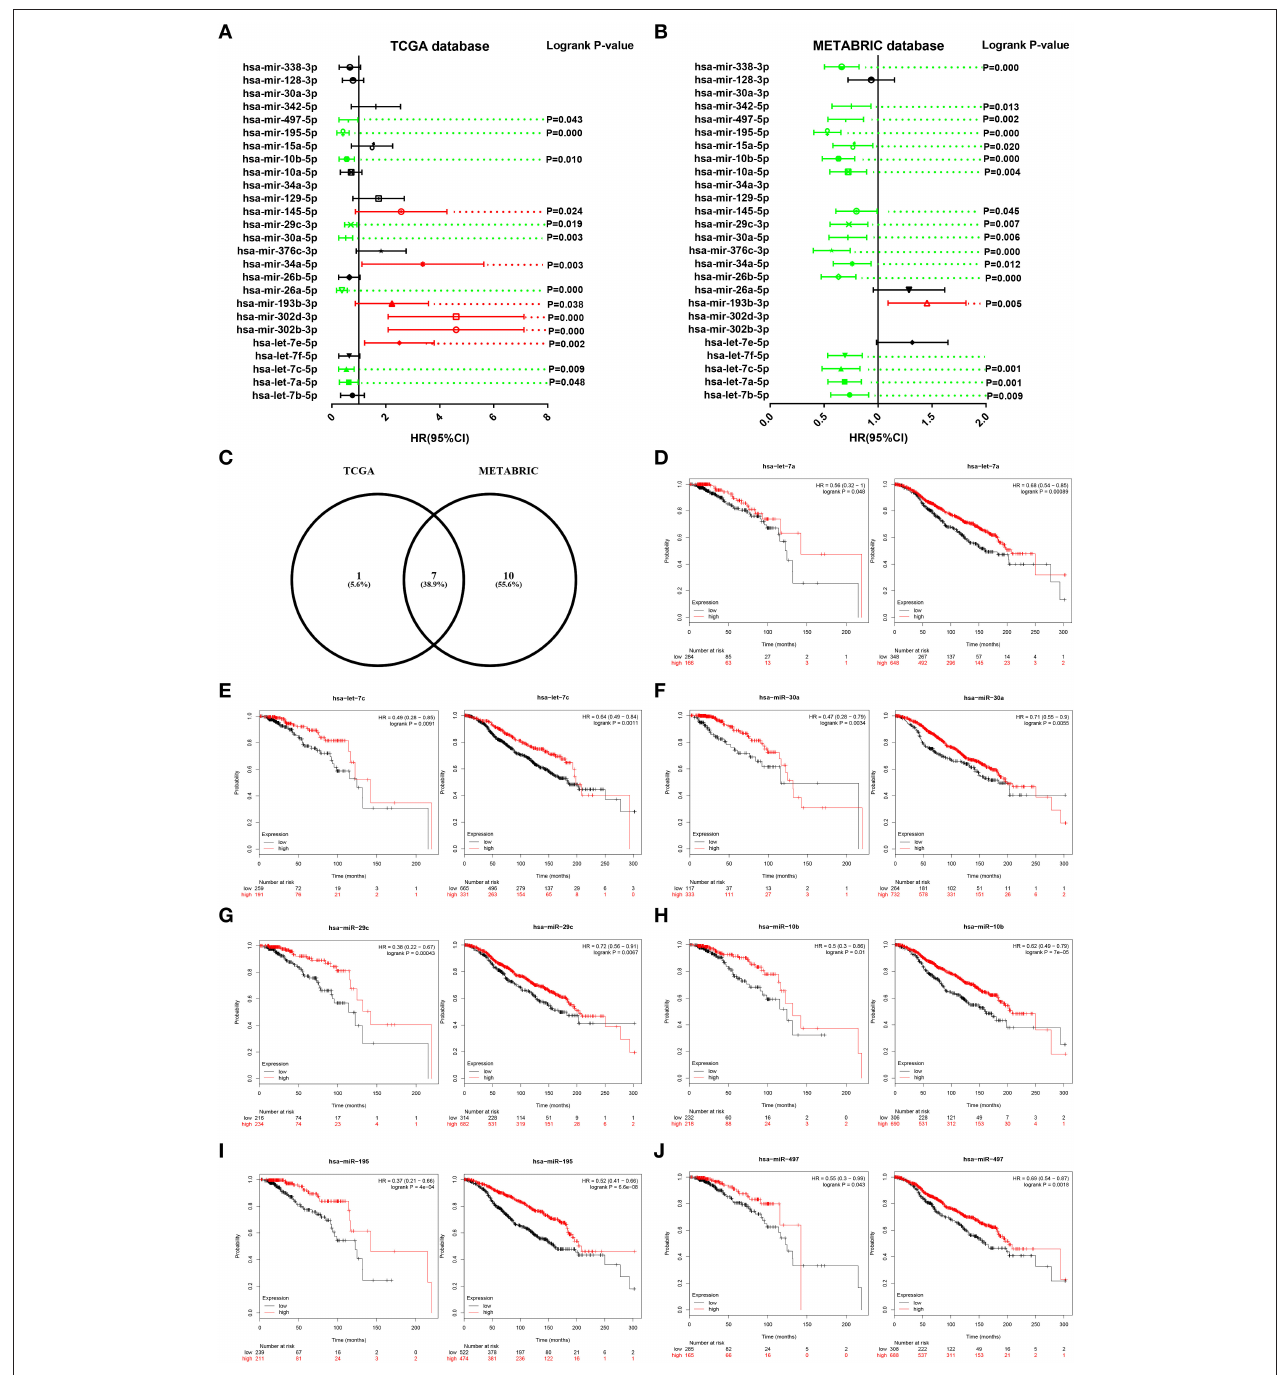
FIGURE 5 | Survival analysis for candidate miRNAs in ER α positive breast cancer based on data from TCGA and METABRIC databases. (A) The prognostic values of candidate miRNAs in ER α positive breast cancer based on data from TCGA database. (B) The prognostic values of candidate miRNAs in ER α positive breast cancer based on data from METABRIC database. Green bars indicated favorable prognosis; red bars indicated unfavorable prognosis; black bars represented no statistical significance. (C) The intersection of miRNA with good prognosis in ER α positive breast cancer based on TCGA and METABRIC databases. (D) The prognostic role of hsa-let-7a-5p in TCGA (left) and METABRIC (right) ER α positive breast cancer. (E) The prognostic role of hsa-let-7c-5p in TCGA (left) and METABRIC (right) ER α positive breast cancer. (F) The prognostic role of hsa-miR-30a-5p in TCGA (left) and METABRIC (right) ER α positive breast cancer. (G) The prognostic role of hsa-miR-29c-3p in TCGA (left) and METABRIC (right) ER α positive breast cancer. (H) The prognostic role of hsa-miR-10b-5p in TCGA (left) and METABRIC (right) ER α positive breast cancer. (I) The prognostic role of hsa-miR-195-5p in TCGA (left) and METABRIC (right) ER α positive breast cancer. (J) The prognostic role of hsa-miR-497-5p in TCGA (left) and METABRIC (right) ER α positive breast cancer.